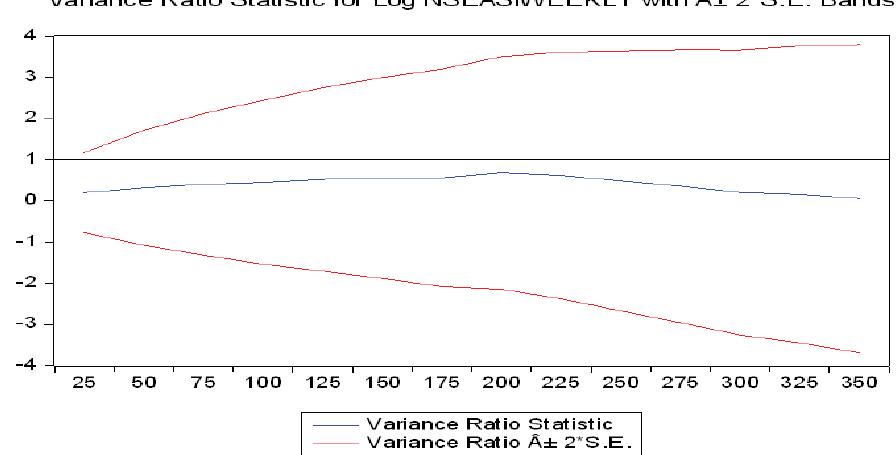
Fig. 4. Graphical illustration of the efficiency of the NSE ASI (weekly data over the test periods: February 2008 to January 2015)